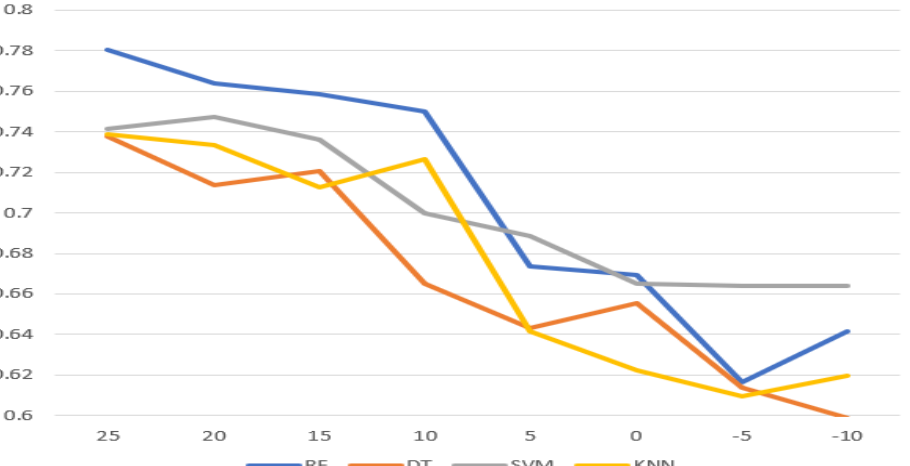
Figure 4. The Flow Diagram of Accuracy of Classification Methods by their SNR by Converting the Com- plex number to Radio Frequency